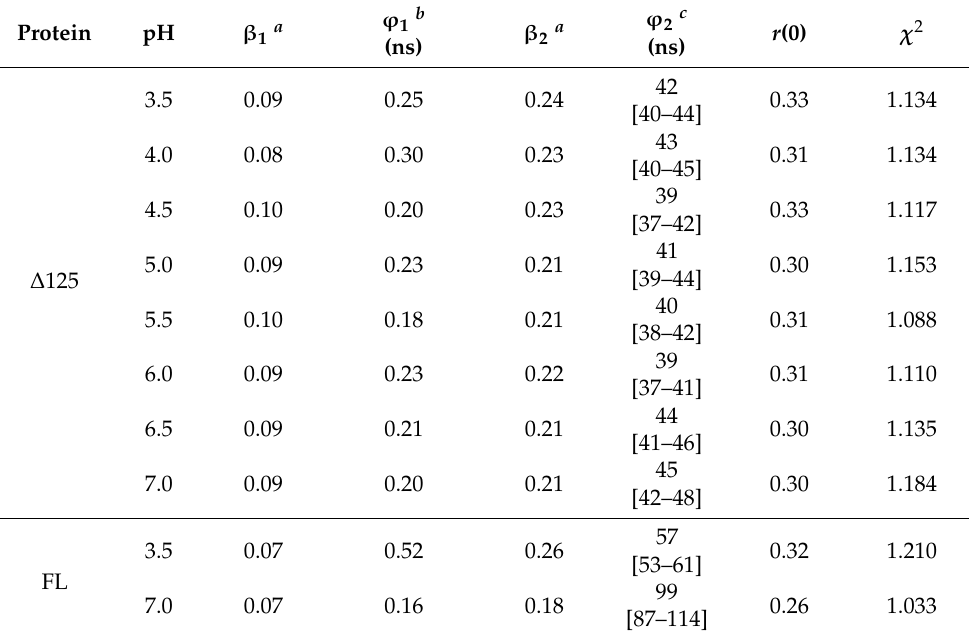
Table 2. Influence of the C-terminal truncation on the fluorescence anisotropy decay parameters for the detergent-solubilized TMR-labeled G116C variant of W67 KcsA. The amplitudes, β i and rotational correlation times, ϕ i , were obtained by fitting a two-exponential function to the anisotropy decay curves obtained for the C-terminal truncated ( ∆ 125) or full-length (FL) fluorescently labeled protein (D:P = 0.60) at pH 3.5–6.5 (10 mM succinic acid, 5 mM DDM, 200 mM KCl) and pH 7.0 (20